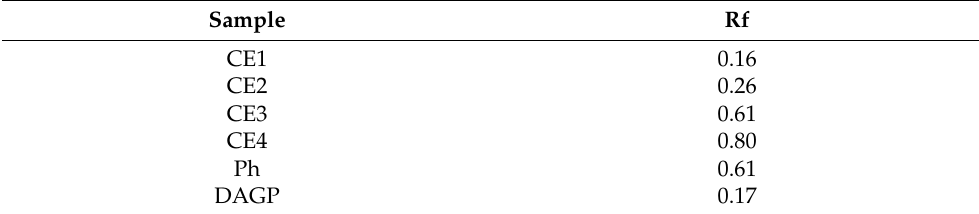
Table 3. In vitro antifungal activity of the cell-free extracts of P. fluorescens and chitosan, alone and combined, on A. alternat a and F. solani development.